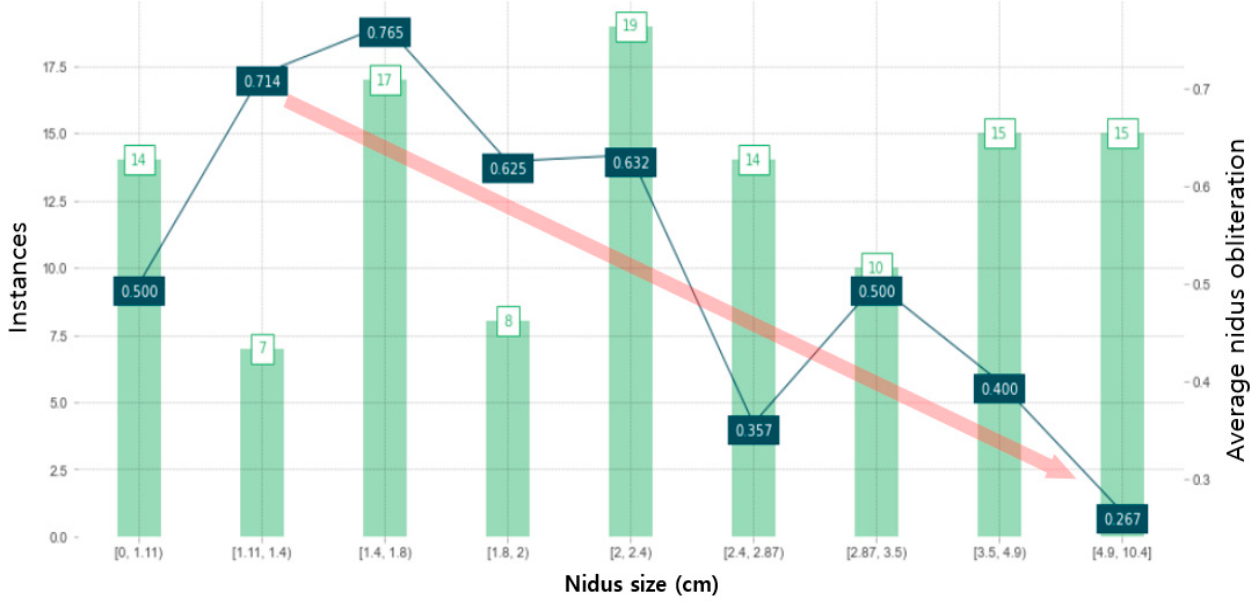
Figure 5. Relationship between nidus size (cm) and obliteration in the 0.4 cm sectional range in the third, fourth, and fifth bars. An obliteration probability of 76.5% for 17 patients with a nidus size ranging from 1.4 to 1.8 cm. In the case of nidus sizes ranging from 4.9 to 10.4 cm, the obliteration probability was 26.7%. The red arrow indicates the trend whereby increases in nidus size led to decreases in the obliteration probability.